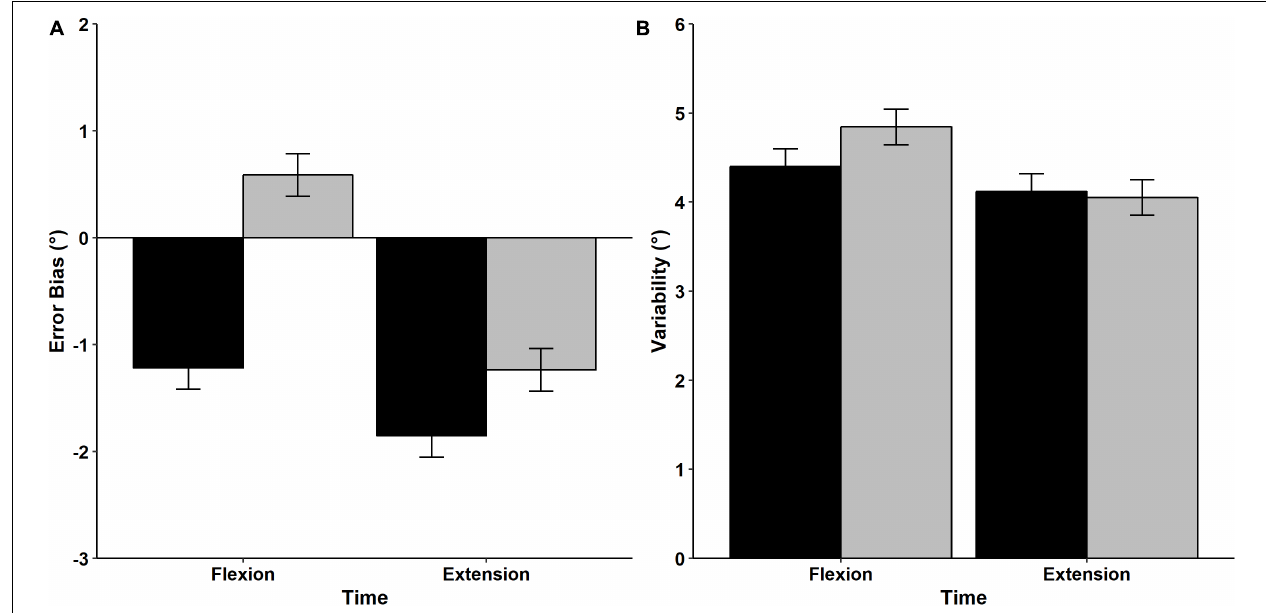
FIGURE 7 | Mean and standard error values of Error Bias (A) and Variability (B) for movements performed in the flexion and extension directions before (black bars) and after (gray bars) the fatigue